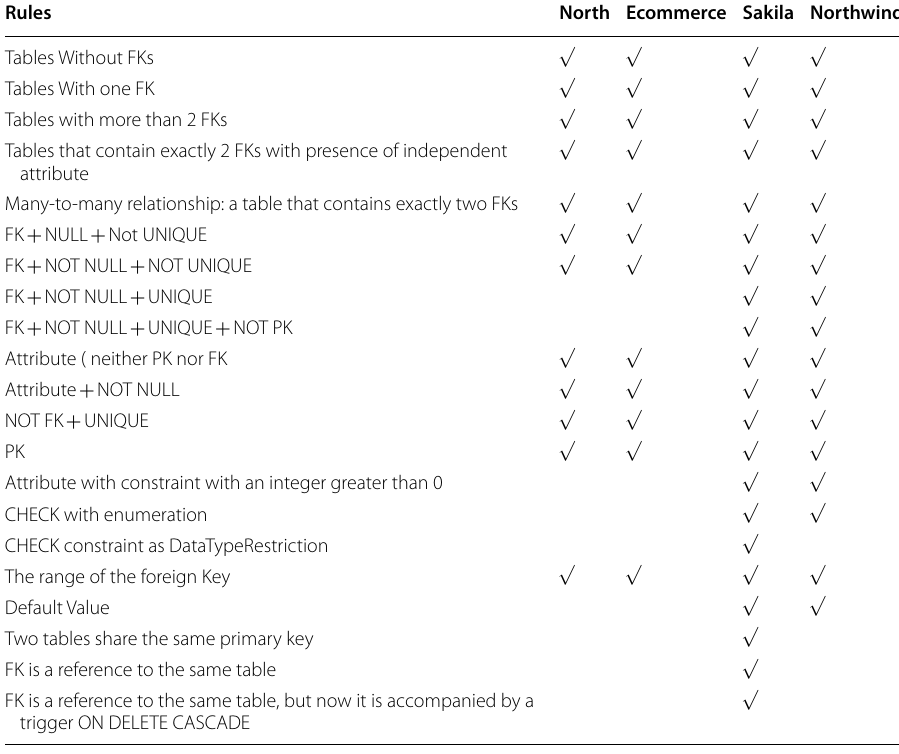
Table 6 The set of patterns